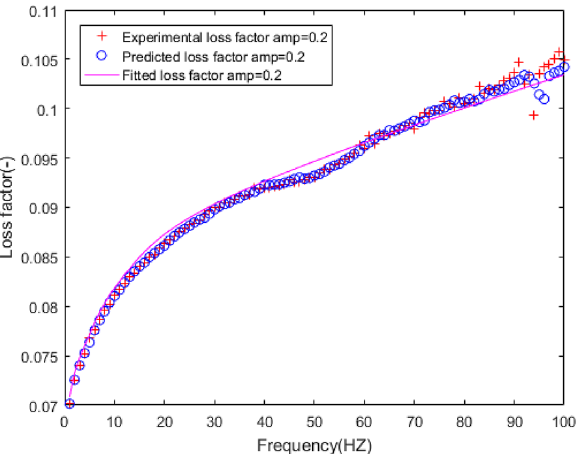
Figure 20. Fitting the curve of loss factor with five-parameter mathematical model under amplitude 0.2 mm.